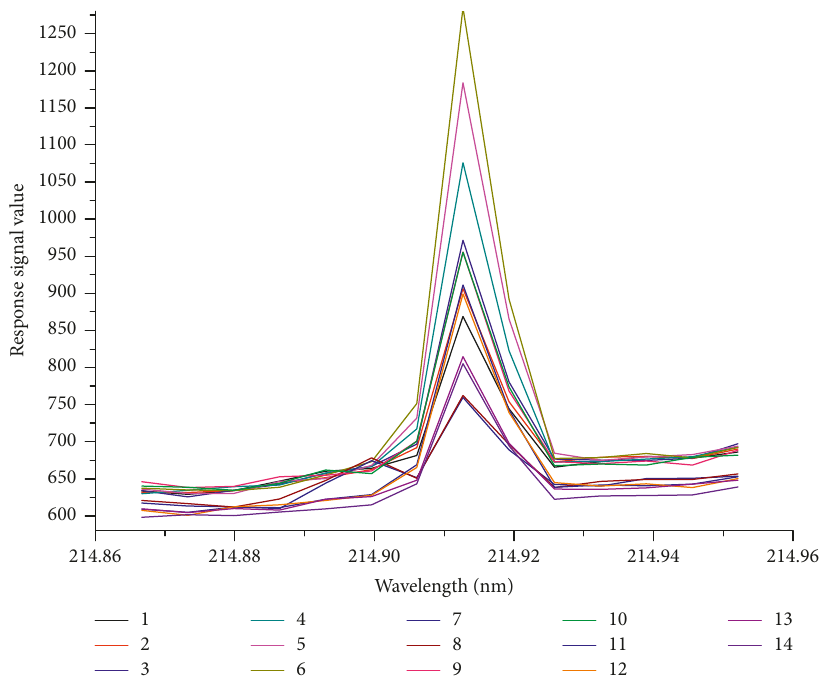
Figure 2: ICP-OES spectrogram of phosphorus with standard solutions diluted by soil mixture solution.